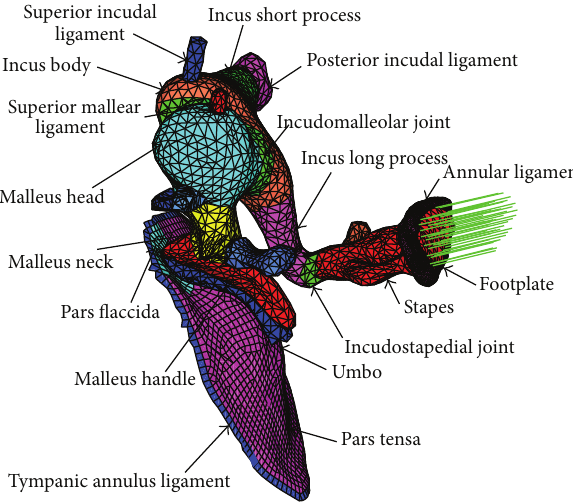
Figure 2: Human middle ear finite element